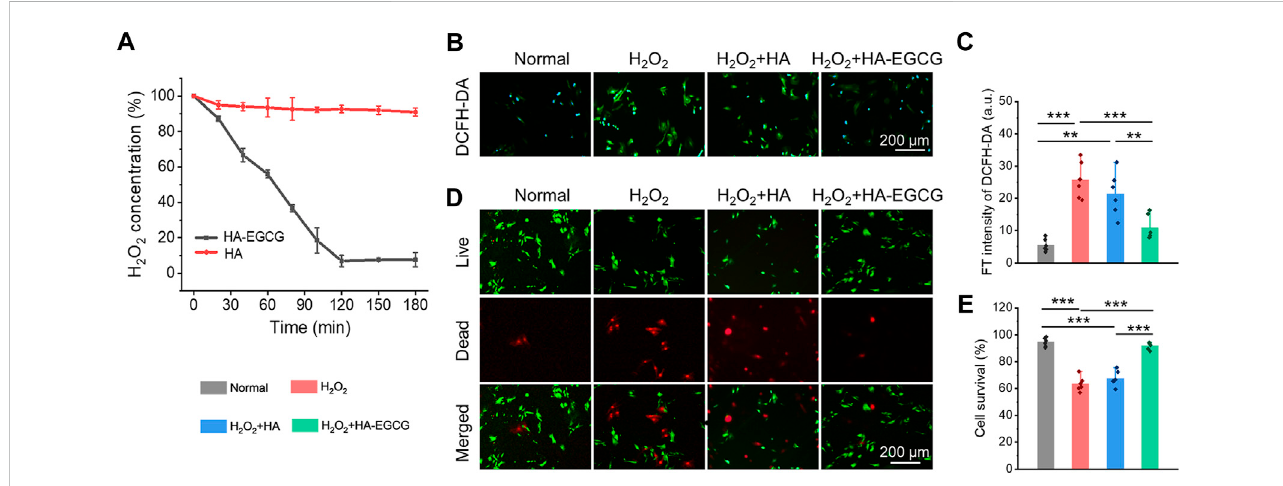
FIGURE 4 ROS-scavenging and cell viability protecting under oxidative stress. (A) Decomposition of H 2 O 2 with HA-EGCG hydrogel and commercial HA (n = 3). (B) Intercellular ROS level validated by a ROS probe (DCFH-DA) after different treatments. (C) The quantitative analysis of fl uorescence intensity of DCFH-DA to evaluatetheROSdepletion. (D) CalceinAM/PIstainingofADSCs. (E) QuantitativeanalysisofthesurvivalratesofADSCs(n=6)(* p < 0.05,** p < 0.01,and*** p < 0.001).